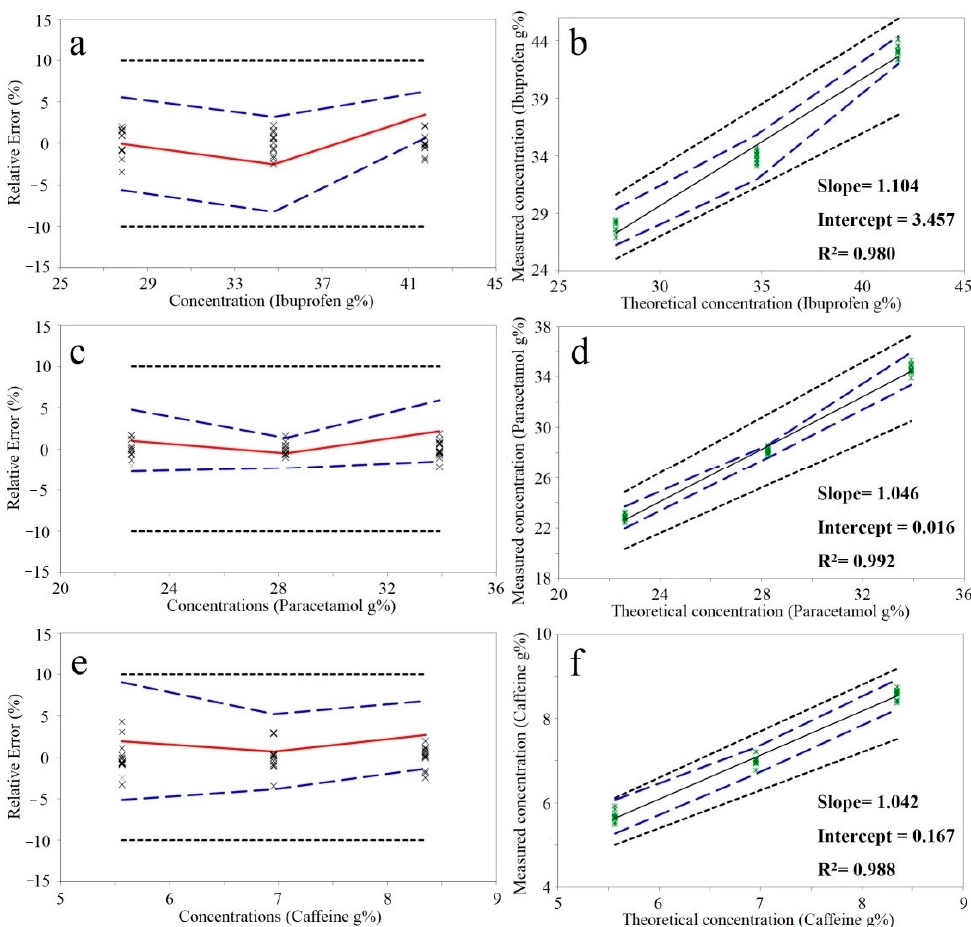
Table 1. PLS model characteristics for active ingredient quantification by